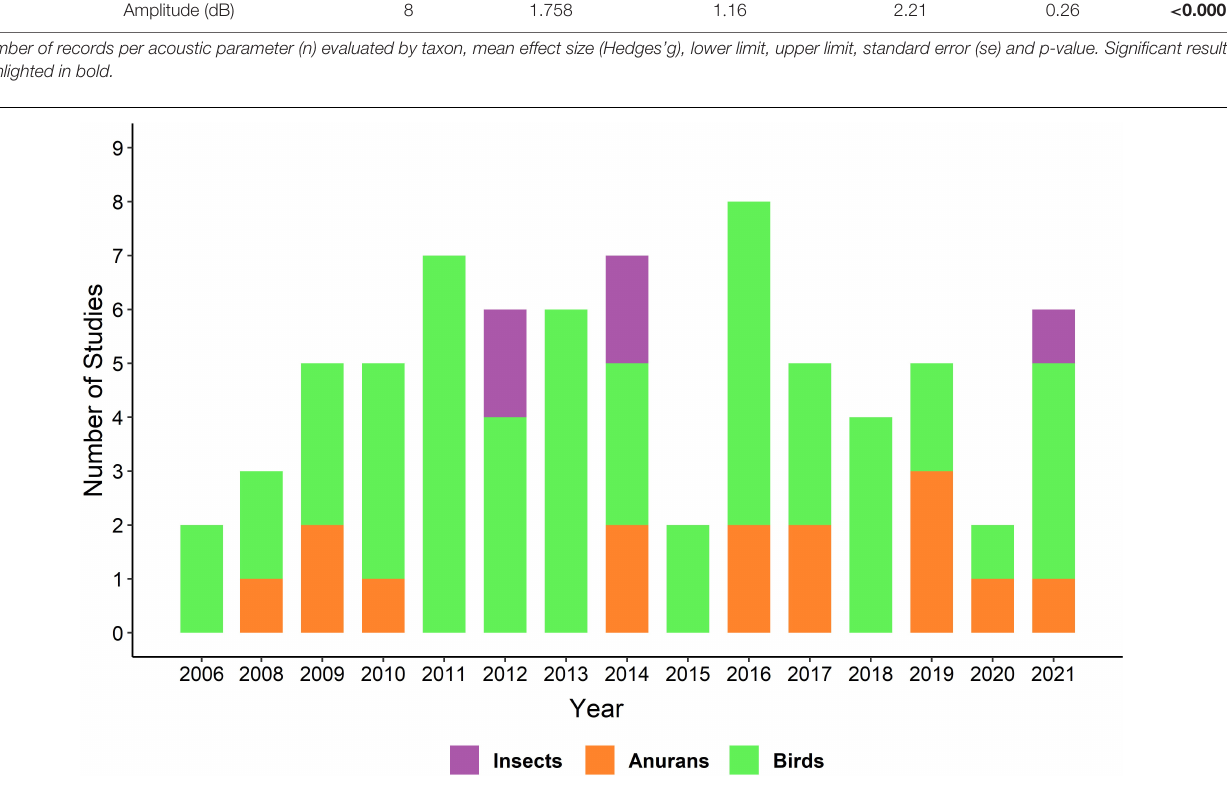
FIGURE 2 | Studies included in the meta-analysis. Number of studies present in our database, separated by year and color-coded